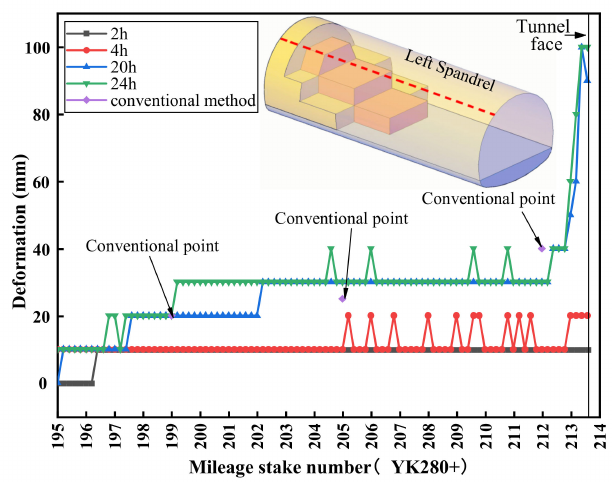
Figure 15. Longitudinal distribution of total deformation of the left spandrel at right line entrance in 24